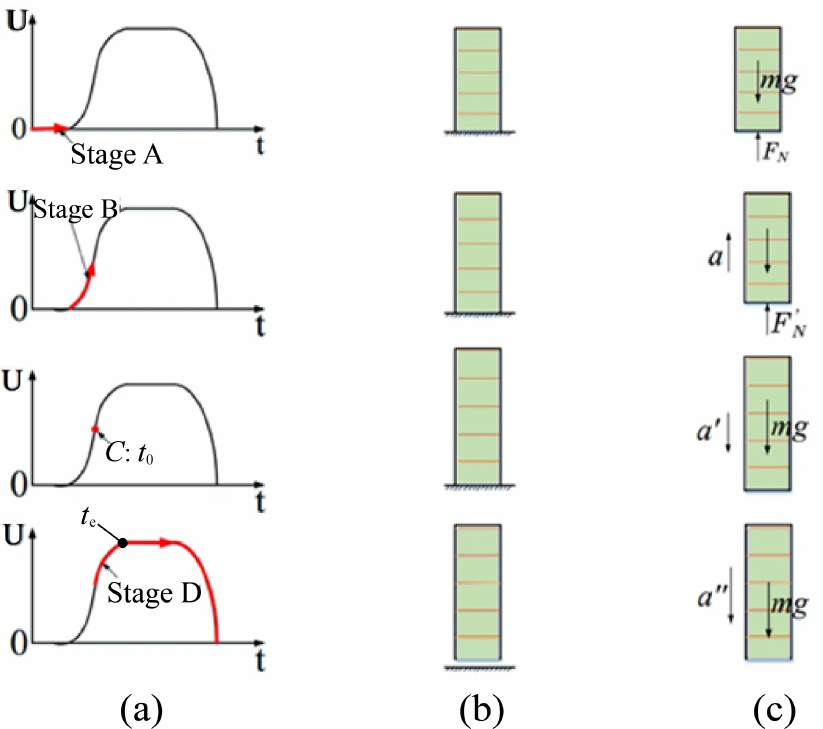
Figure 2. Motion and force analysis of piezoelectric actuator without load. ( a ) Excitation voltage diagram of the piezoelectric actuator; ( b ) State of the piezoelectric actuator; ( c ) Force analysis diagram of the piezoelectric